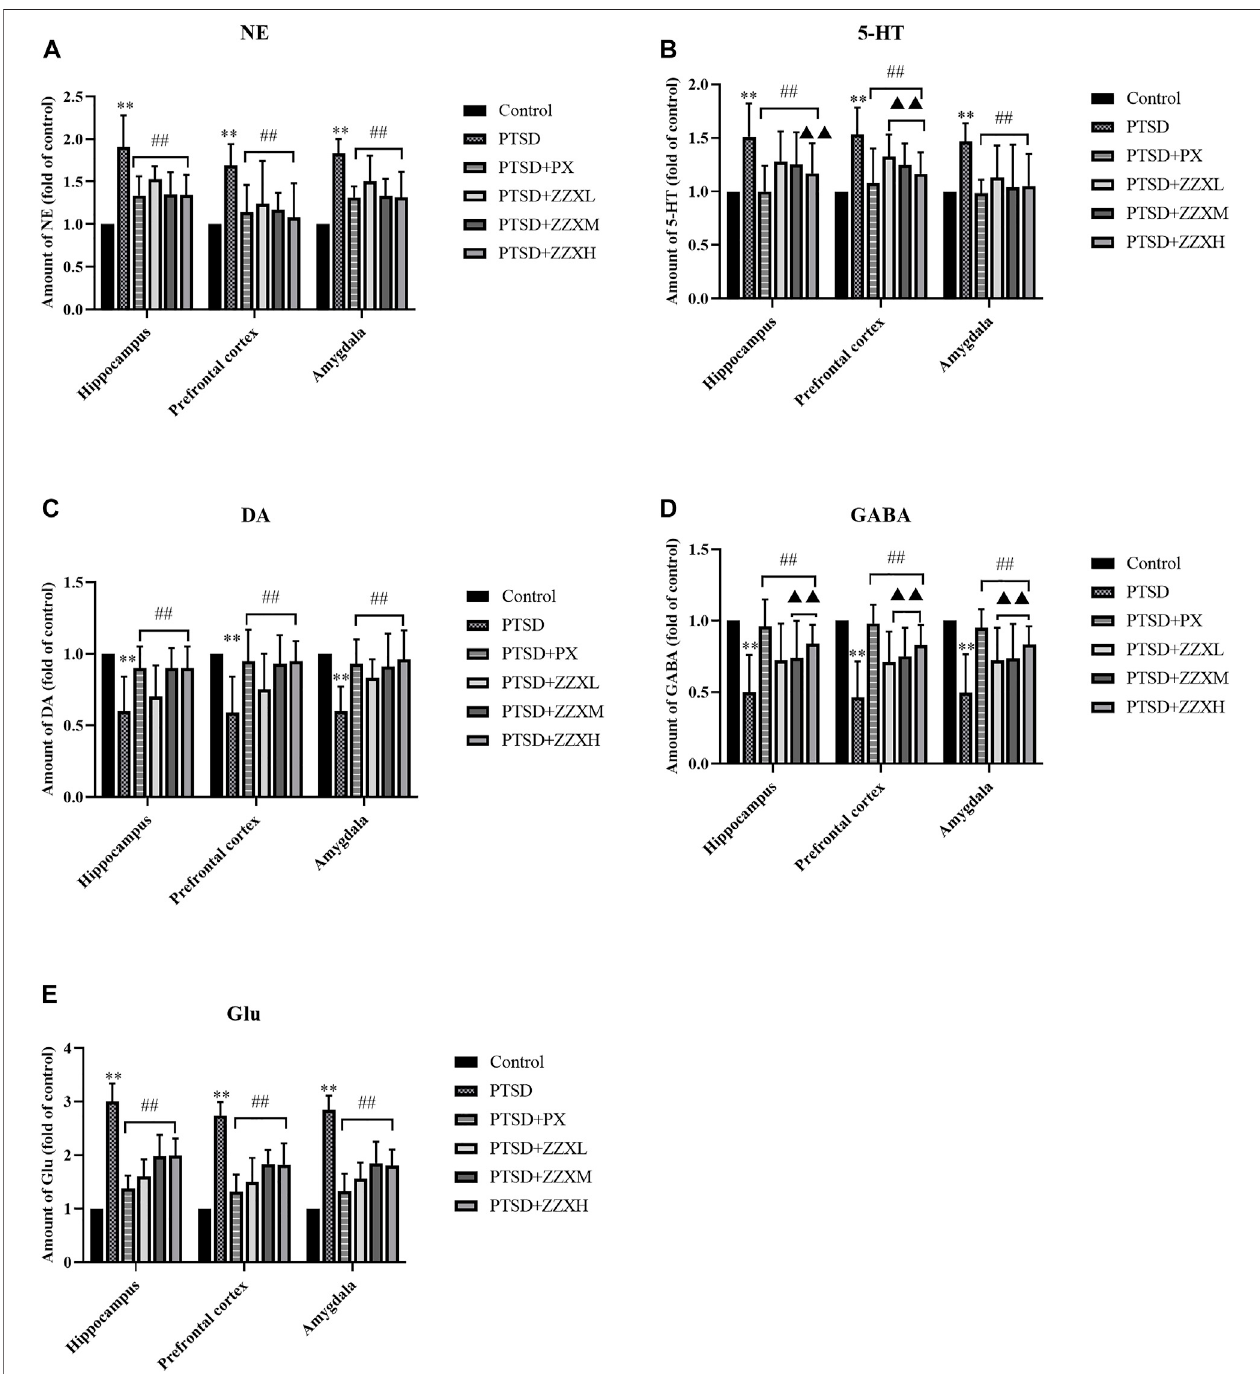
FIGURE 7 | Effects of ZZX treatment on 5-HT, NE, DA, GABA, and Glu (A – E) levels in different brain regions of mice. Values are expressed as (mean ± SEM, n (cid:2) 10 – 15). * p < 0.05, ** p < 0.01 vs control group. # p < 0.05, ## p < 0.01 vs PTSD group. ▲ p < 0.05, ▲▲ p < 0.01 vs ZZXM group.